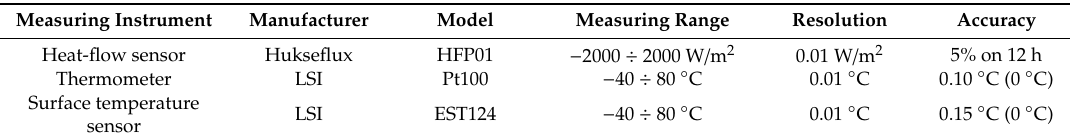
Figure 3. Measurement apparatus schema. Table 1. Measuring instruments technical data.